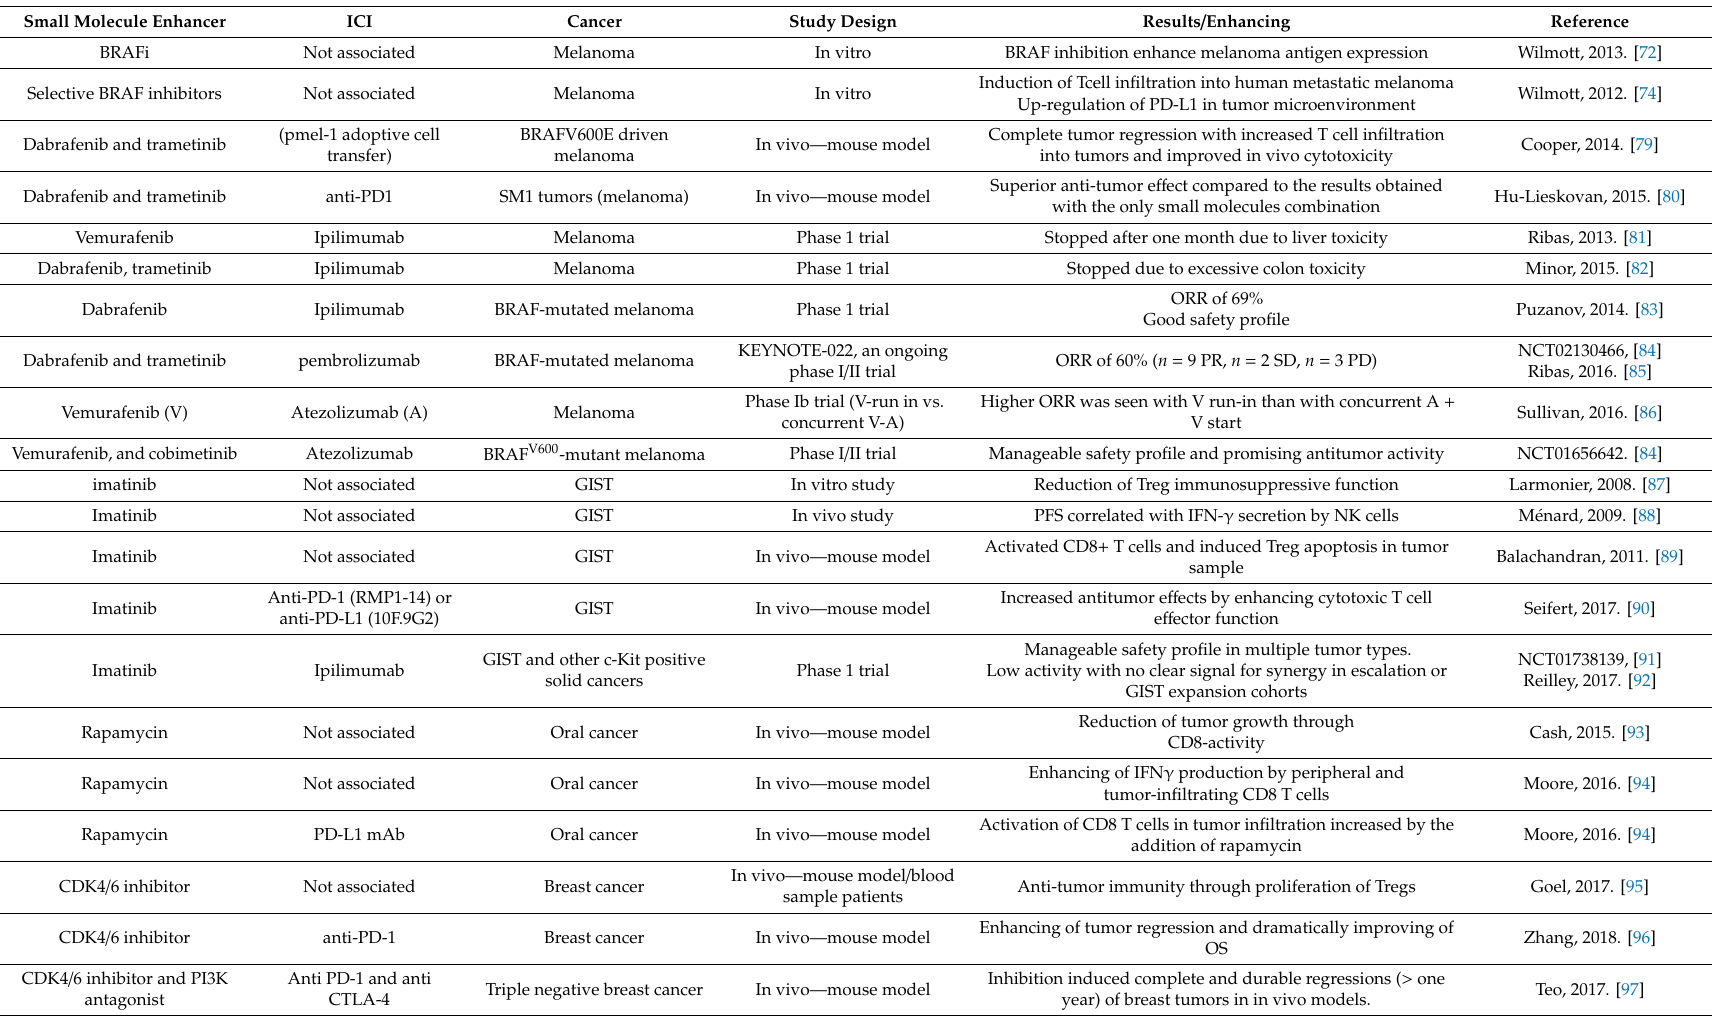
Table 2. Small Molecule Inhibitors and